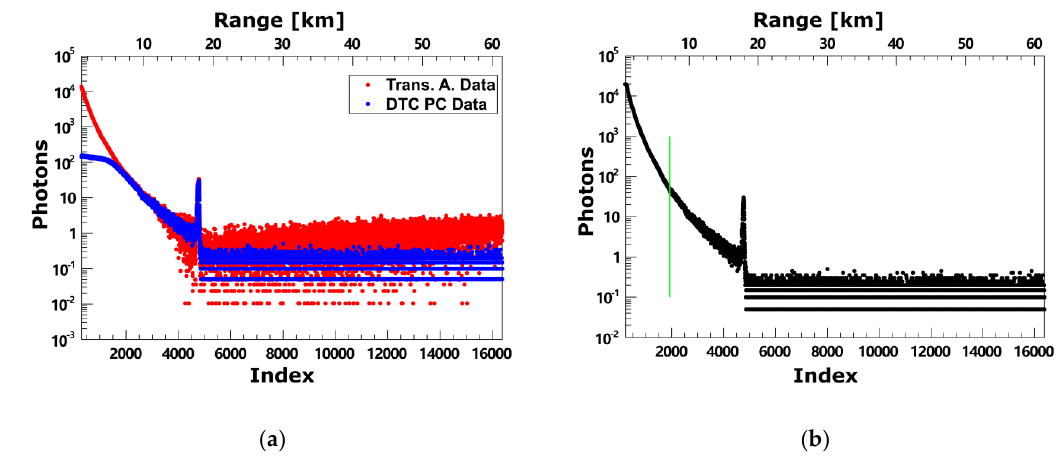
Figure 11. Spatial variances of lidar analog data and its corresponding transformed photon-counting data for determination of the transfer coe ffi cients of a and b .